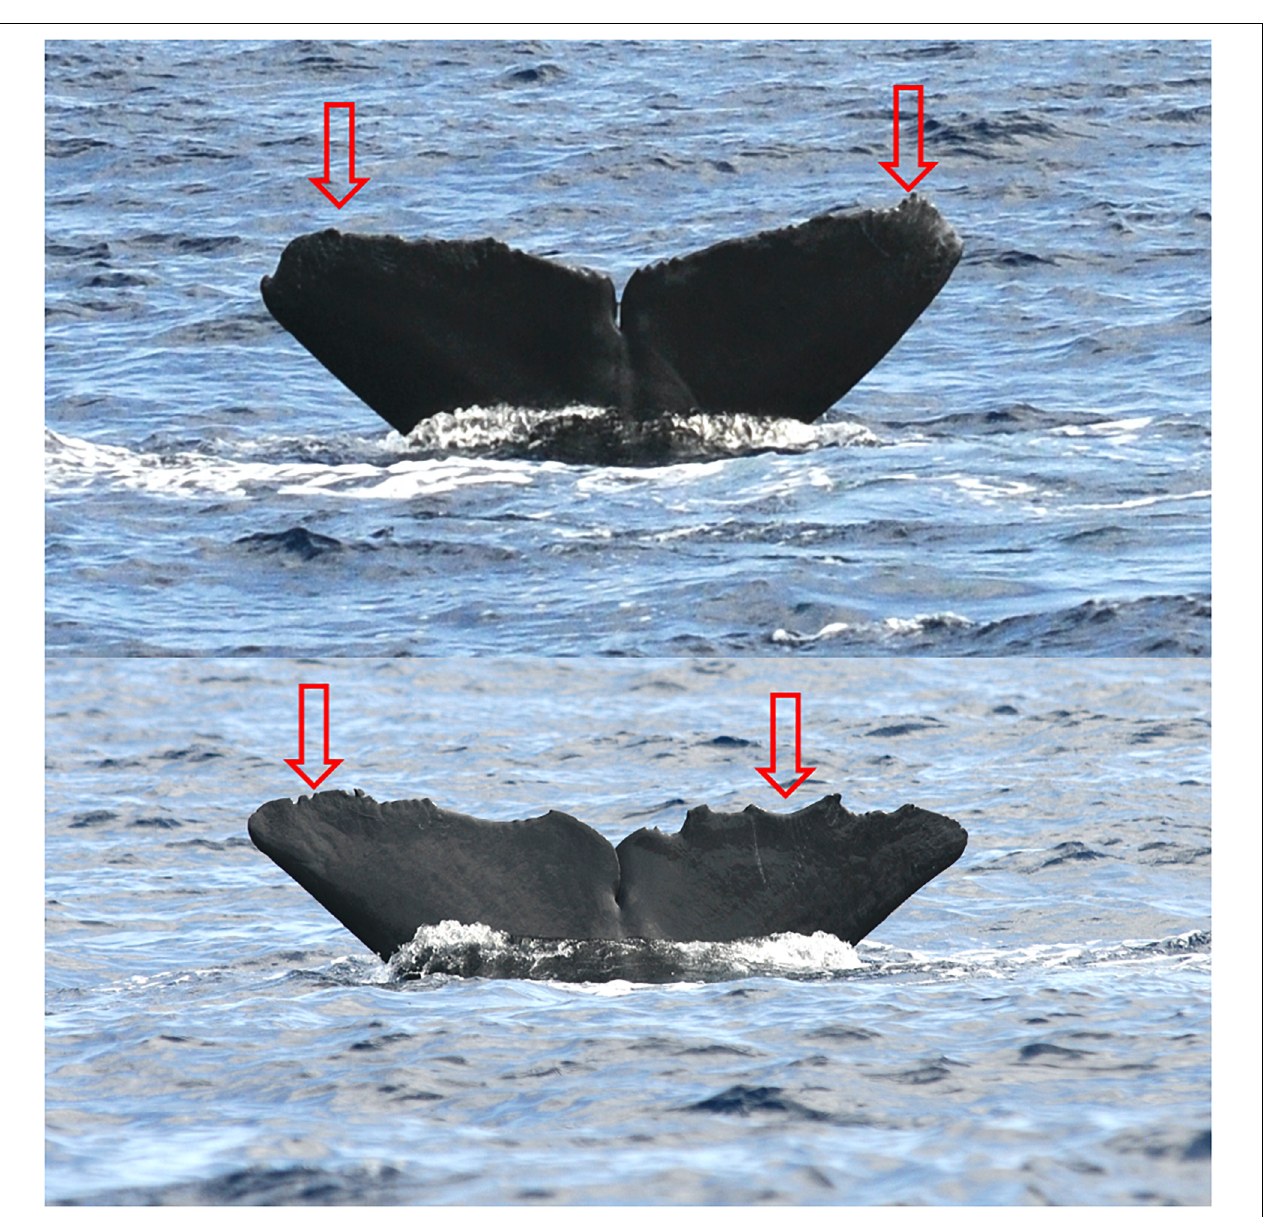
FIGURE 3 | Tooth rake marks possibly caused by killer whales ( Orcinus orca ) on adult sperm whales ( Physeter macrocephalus ) photographed off the west coast of Guadeloupe (French West Indies) in 2014 and 2015 (Photographs: Laurent Bouveret], OMMAG).